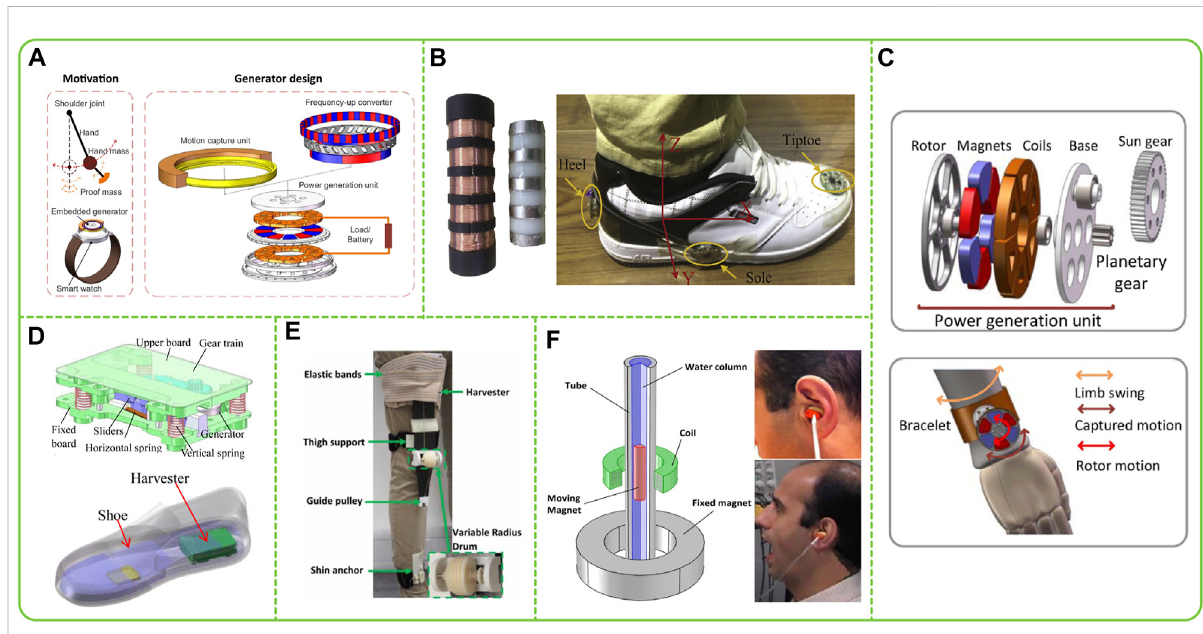
FIGURE 3 Electromagnetic EH from human motion. (A) Design and exploded view of the electromagnetic generator (Cai et al., 2020a). (B) Photograph of MLPMG (Cai and Liao, 2021). (C) Architecture of the inertial energy harvester (Xie and Cai, 2015). (D) 3-D model of the in-shoe energy harvester (Gui et al., 2018). (E) The components of the proposed human knee energy harvester (Chan et al., 2021). (F) Model and experimental setup of the in-ear energy harvester (Delnavaz and Voix, 2014).